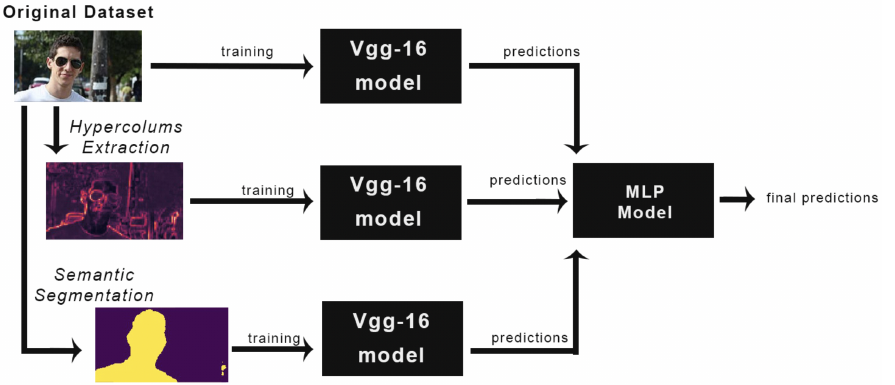
Figure 5. Methodology